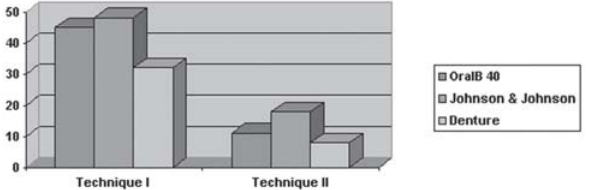
FIGURE 1- Comparison of the sum of means (%) for 3 brushes in each technique and comparison of